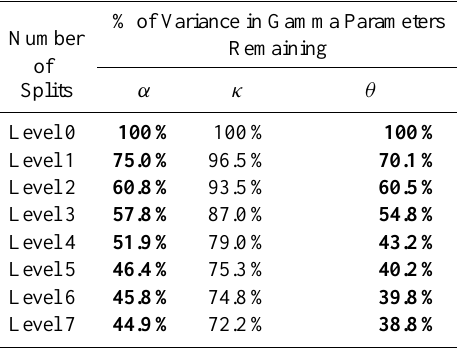
Table 2. Variance reduction in parameters of the mixed gamma dis- tribution sorted by catchment